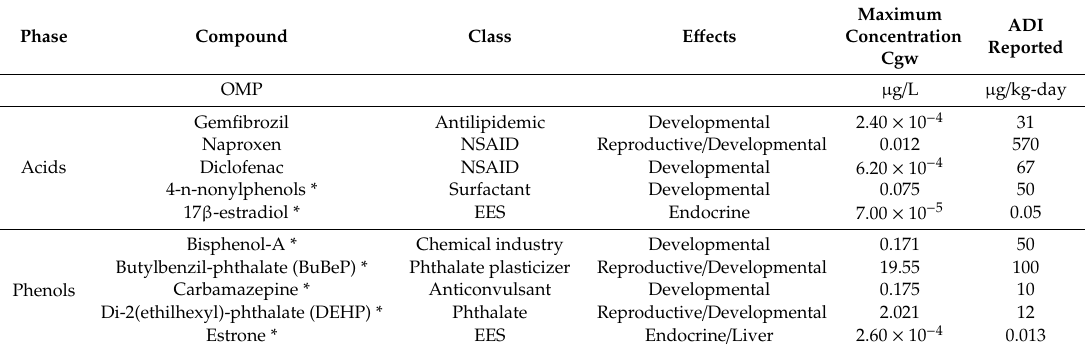
Table 2. Concentrations and acceptable daily intakes (ADIs) used for EDC risk analysis.